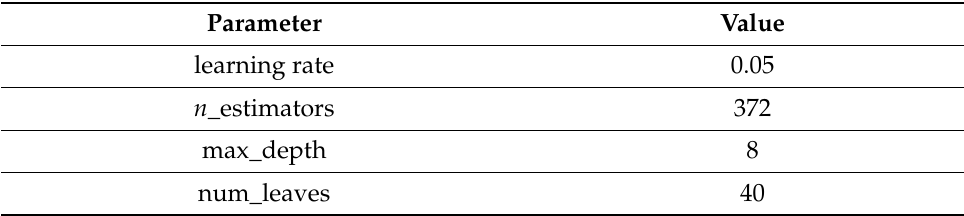
Table 2. Parameter list for LightGBM.